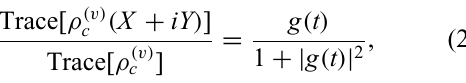
Algorithm 1. Single-control